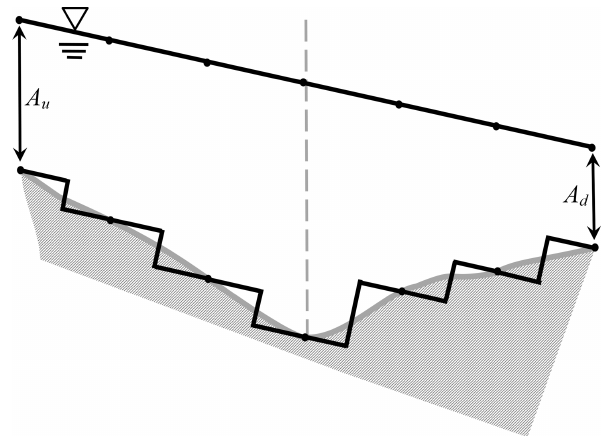
Figure 7. Non-monotonic stair steps of the cross-sectional area with linear monotonic free surface. The dashed gray line is where the cross-section area reverses from increasing to